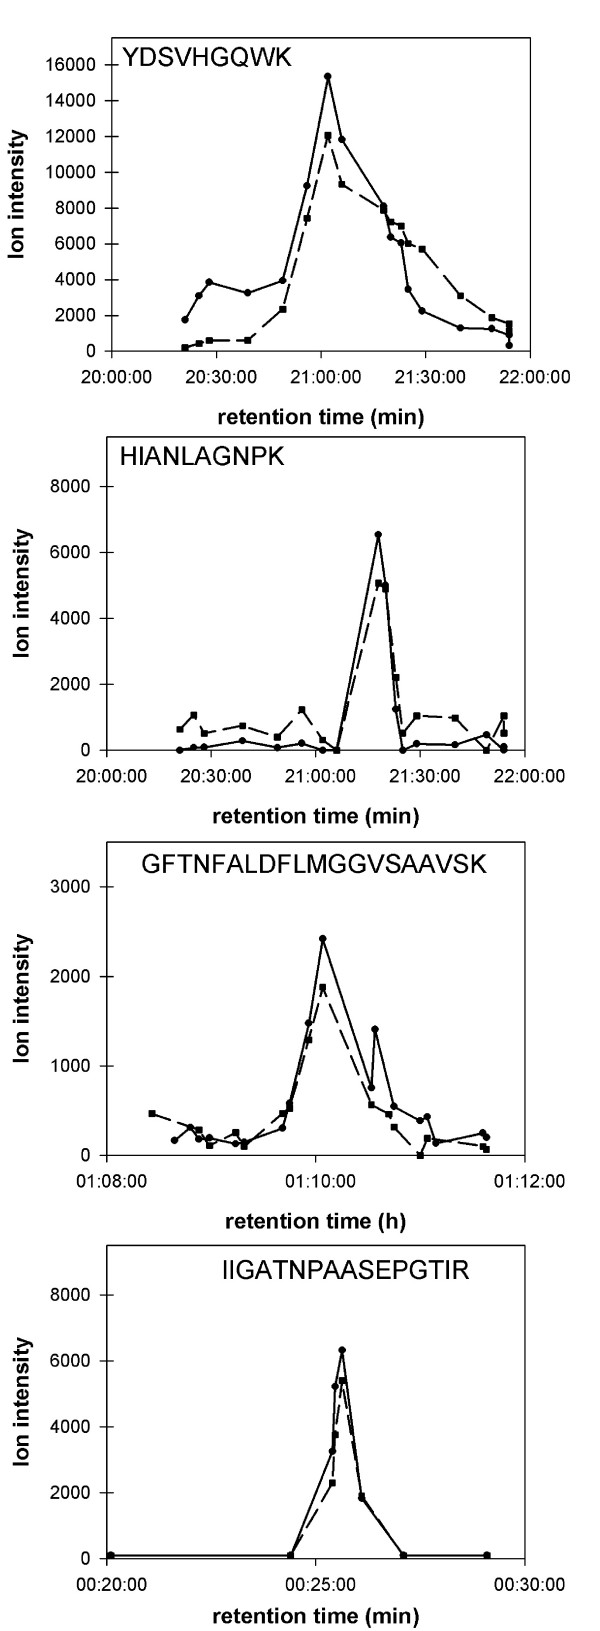
Co-Elution of unlabeled and labeled peptides. Solid lines mark the elution peak of the unlabeled form of each peptide, dashed lines mark the elution peak of the corresponding labeled peptide.